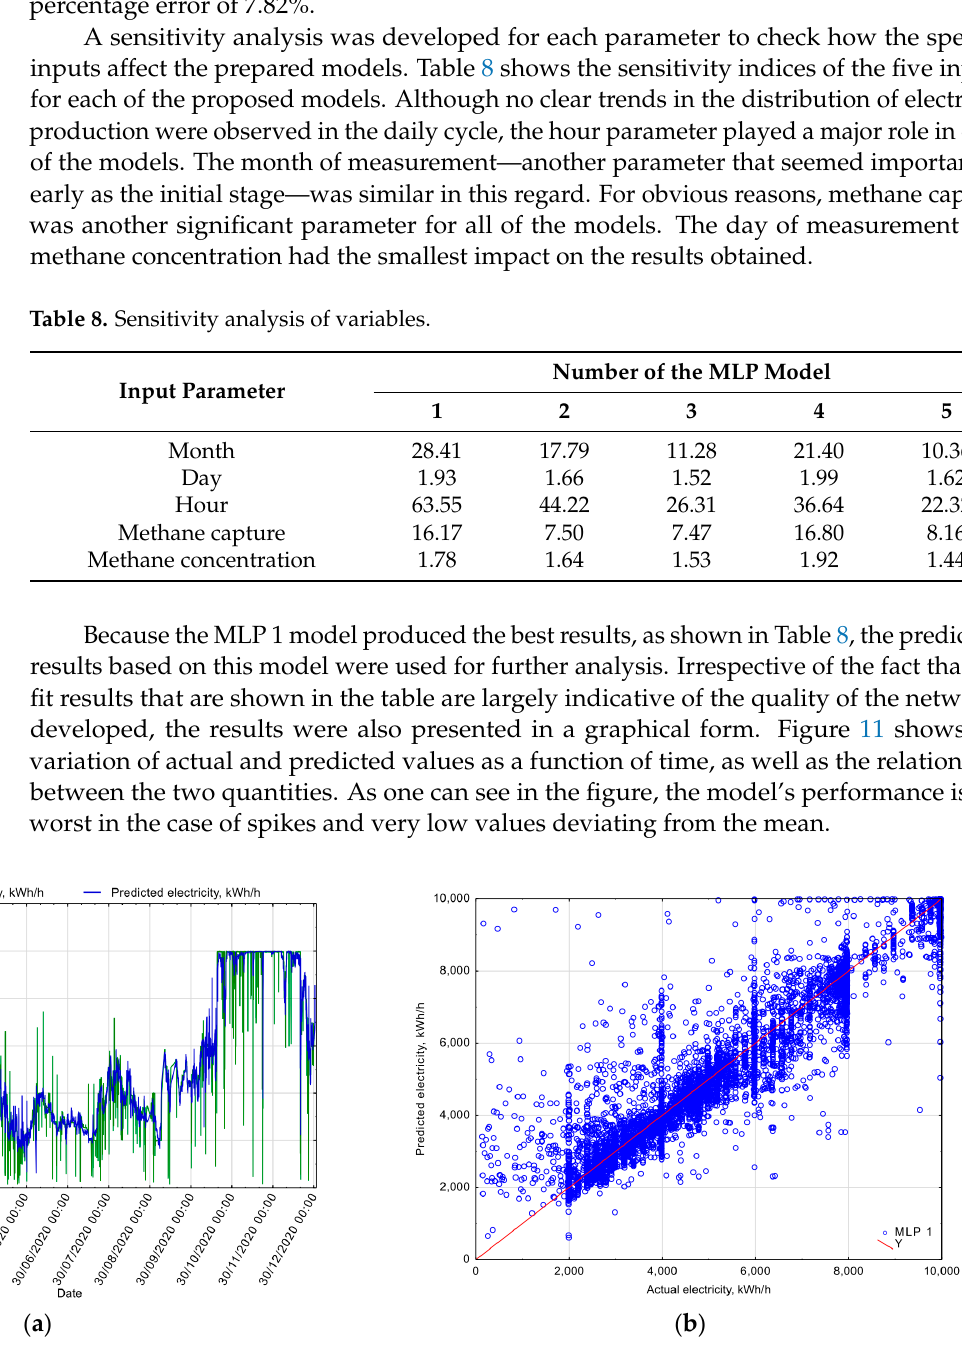
Figure 11. The prediction result of MLP 1 ( a ) Actual and predicted values for analyzed period; ( b ) Regression performance of model—predicted against the actual values.